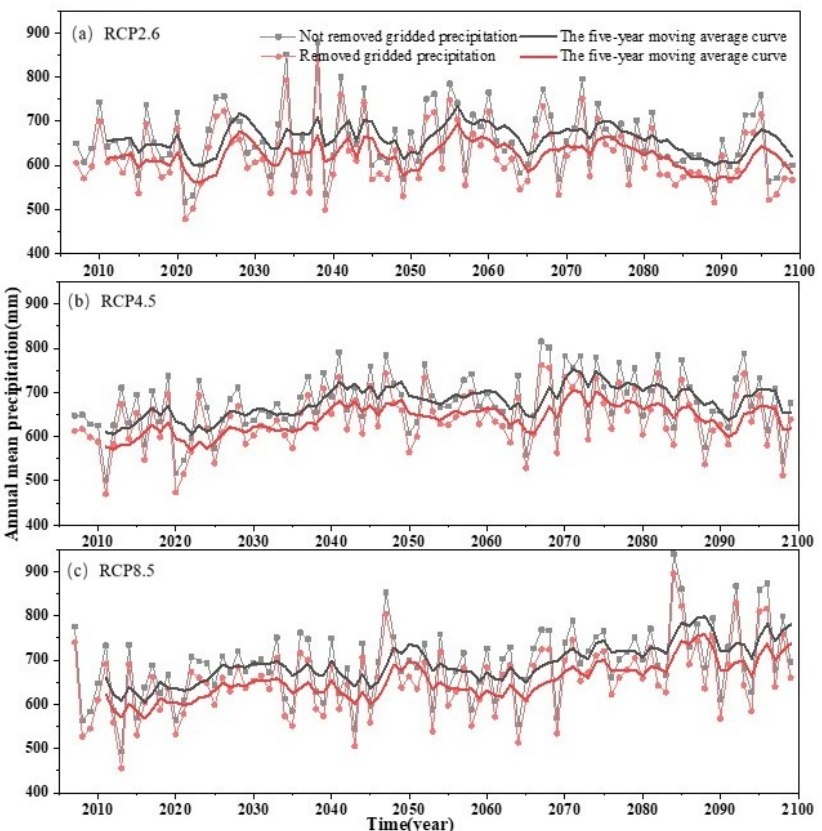
Figure 5. Comparison of future precipitation changes under different climate change scenarios, ( a ) RCP2.6 ( b ) RCP4.5 ( c ) RCP8.5.